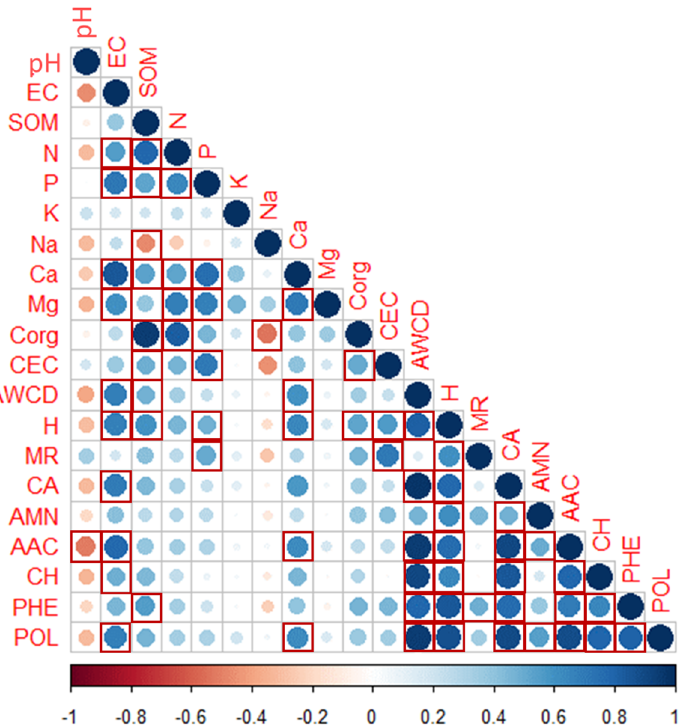
Figure 4. Spearman’s rank correlations (RHO) of the soil physico-chemical properties and community-level physiological profiles (characterized after 96 h of incubation) of the burned plots in the MedForECOtron plots at three different times (PRE, 1Dafter, and 180Dafter) at three burn severity levels (UB, LOWsev, and HIGHsev). Dark tones mean strong correlation (either positive (in blue) or negative (in red)), whereas light tones or white color mean weak (or lack of) correlation.